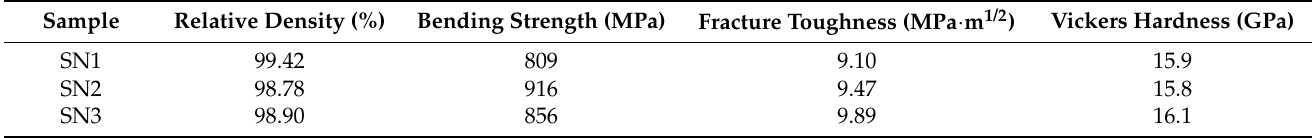
Table 2. Effect of TiC 0.7 N 0.3 content on the mechanical properties of